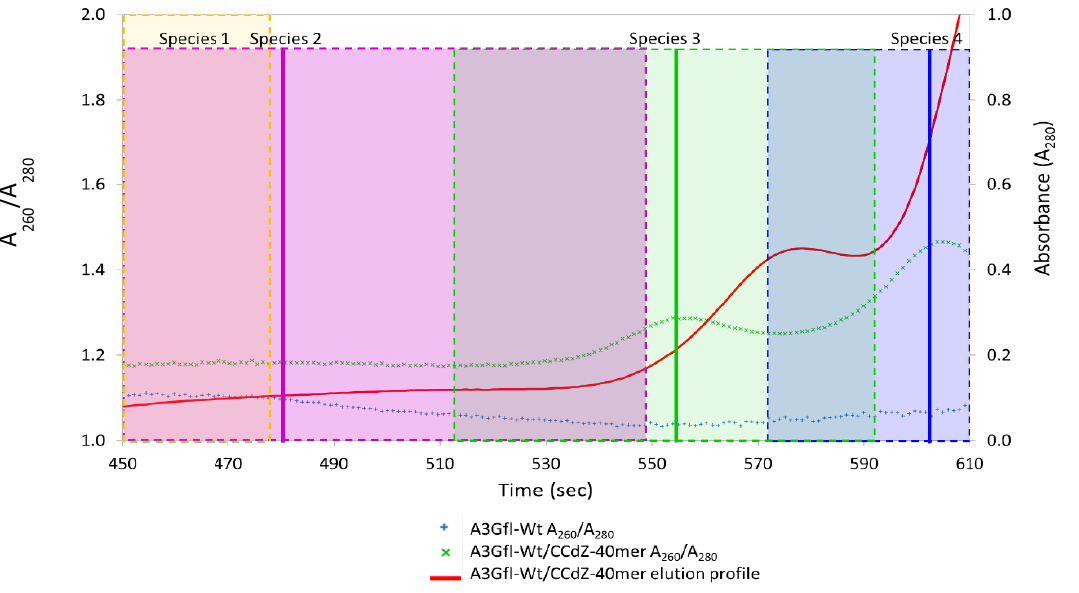
Figure 5. Ratio of A260/A280 to assess the presence of DNA in elution of the A3G fl /CCdZ-T30-oligo sample. The A260/A280 ratio of the A3G fl (blue) and A3G fl /CCdZ-T30-oligo (green) samples (abbreviated as CCdZ-40mer in the figure), overlaid with the A280 elution profile of the A3G fl /CCdZ-T30-oligo sample (red) to display the boundaries of each species (Species-1, -2, -3 and -4). The peak maxima for the deconvoluted data are shown with a solid line; the peak width with a dotted rectangle and shaded box. Note: Peak widths for Species-1 and -4 extend to the left and to the right of the chromatograph, respectively. The color scheme is the same as in Figure 4. The overlap between the scattering of species results in the mixed colors.